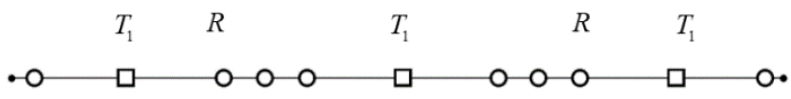
Figure 16. Transmitter and receiver placement sequence in homogeneous line BR barrier (Squares denote transmitters and circles denote receivers).